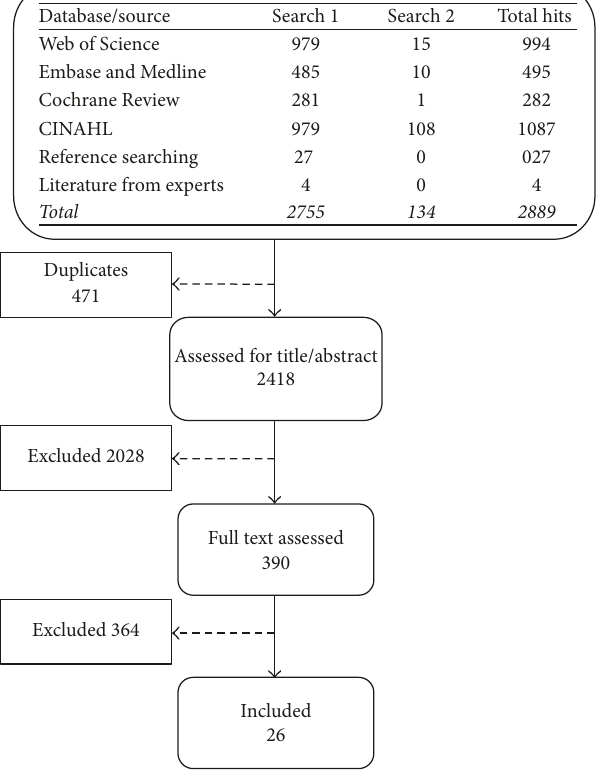
Figure 1: Prisma of search